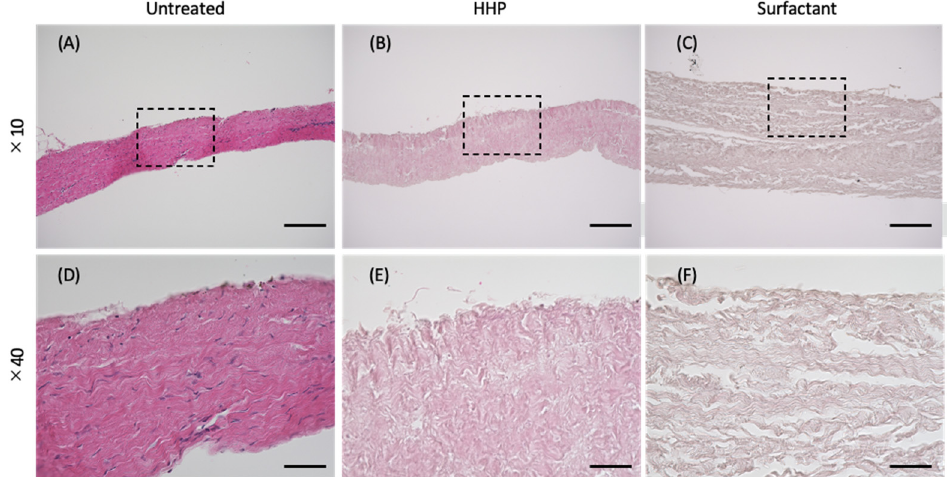
Figure 2. H&E staining of the ( A , D ) untreated, ( B , E ) HHP-decellularized, and ( C , F ) surfactant-decellularized pericardia. Scale bars: ( A – C ) 200 µm, ( D – F ) 50 µm. Nuclei can be observed in black in images ( A , D ), but are absent after the decellularization ( B , C , E , F ).